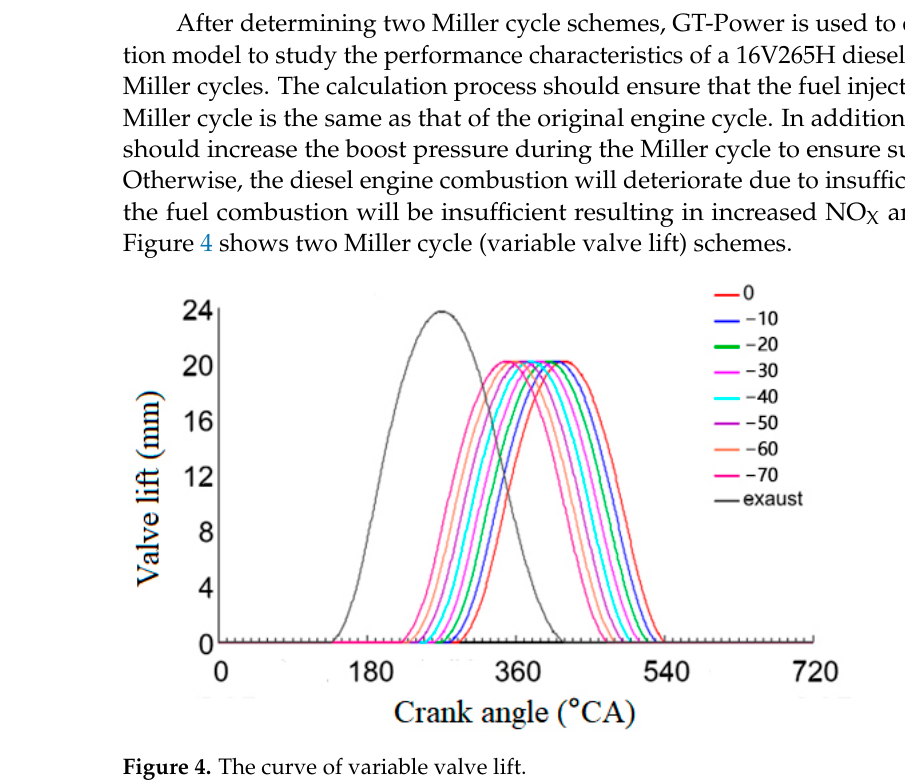
Figure 4. The curve of variable valve lift.